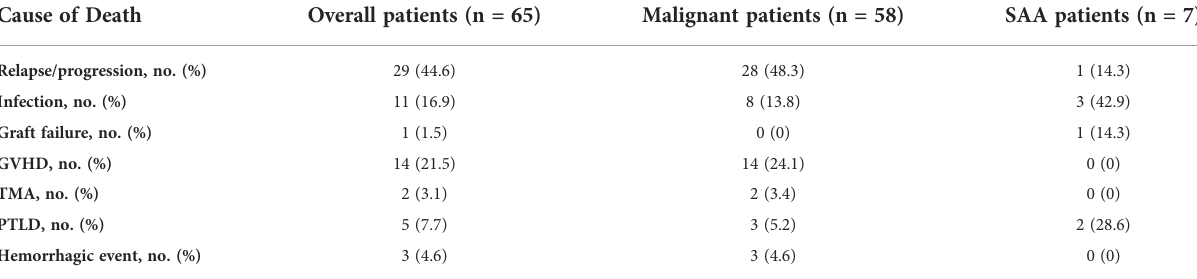
TABLE 3 Cause of